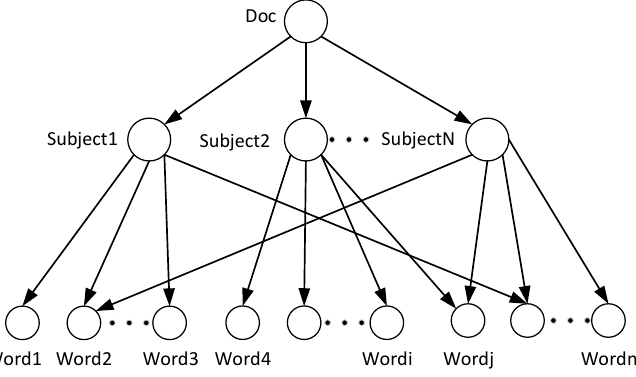
Figure 4. LDA model potential subject topology diagram.